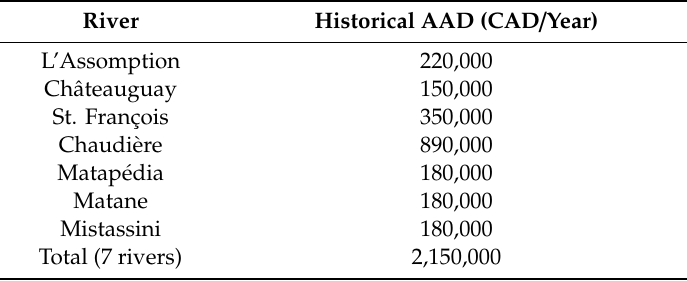
Table 6. Annual average damage (AAD) associated with ice-jam floods for the historical period (1972–2000 or 1982–2010), based on 1991–2014 MSP data for each studied river. All the values are expressed in 2017